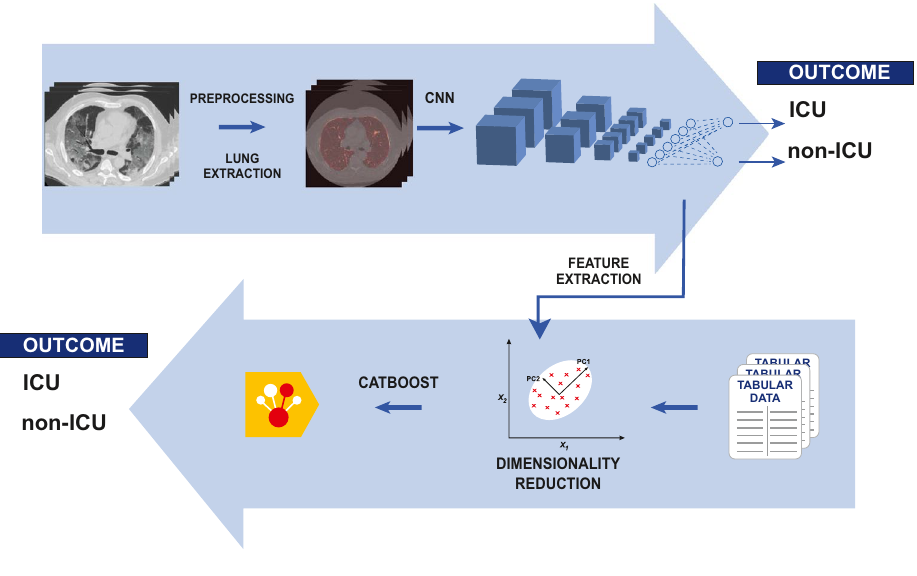
Figure 1. A graphical representation of the proposed